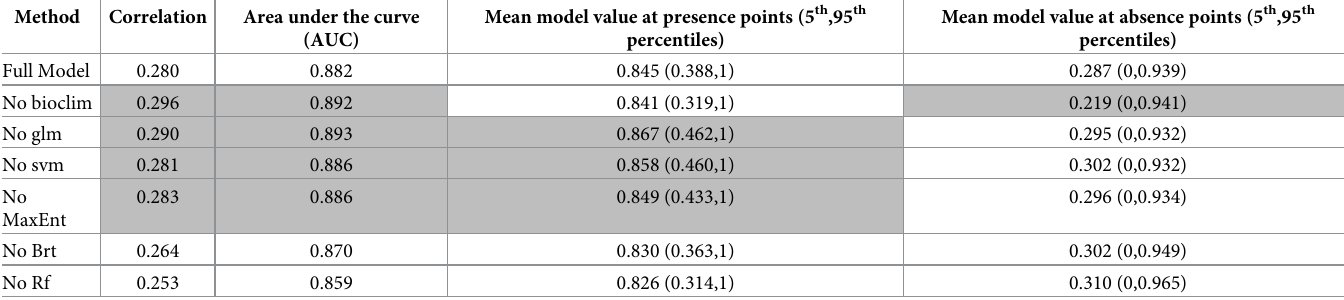
Table 3. Goodness of fit statistics for the full consensus model and consensus models without individual models. Statistics that are better compared to the full consen- sus model are shaded in